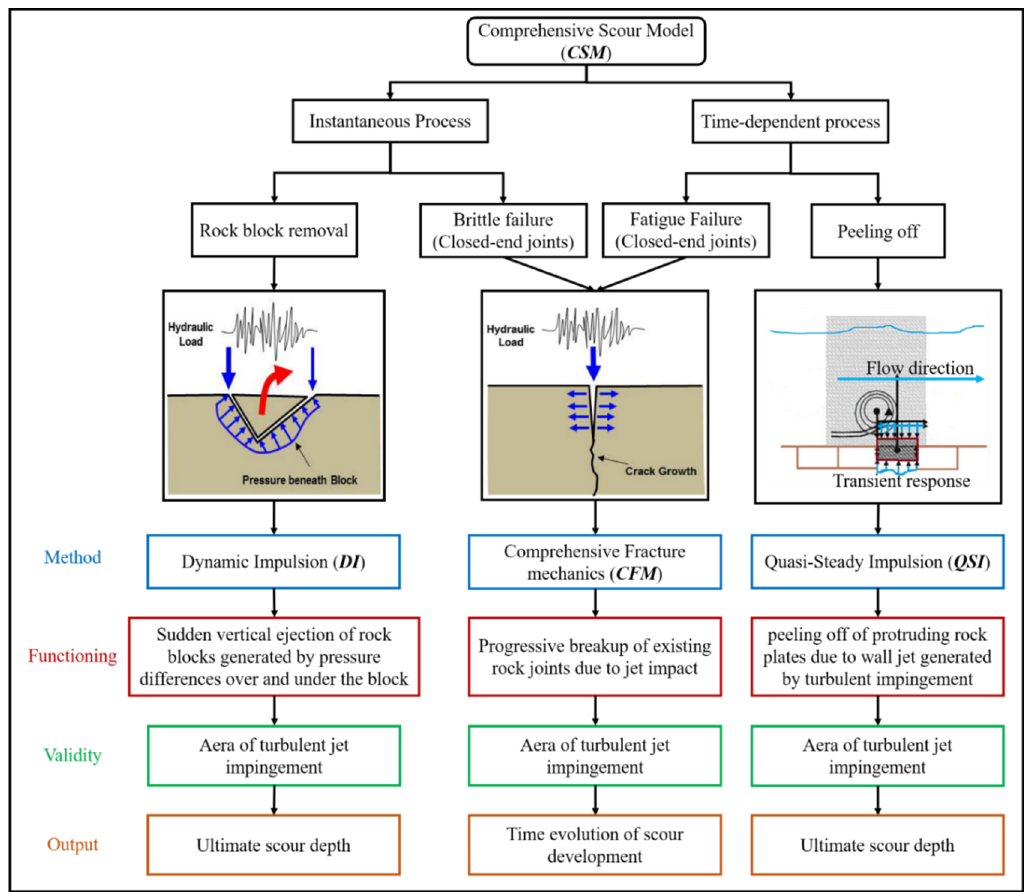
Figure 7. Description of CSM.